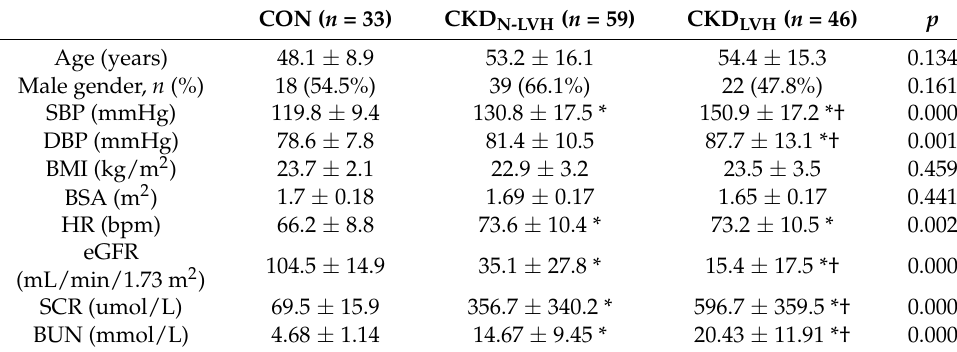
Table 1. Clinical and laboratory characteristics.